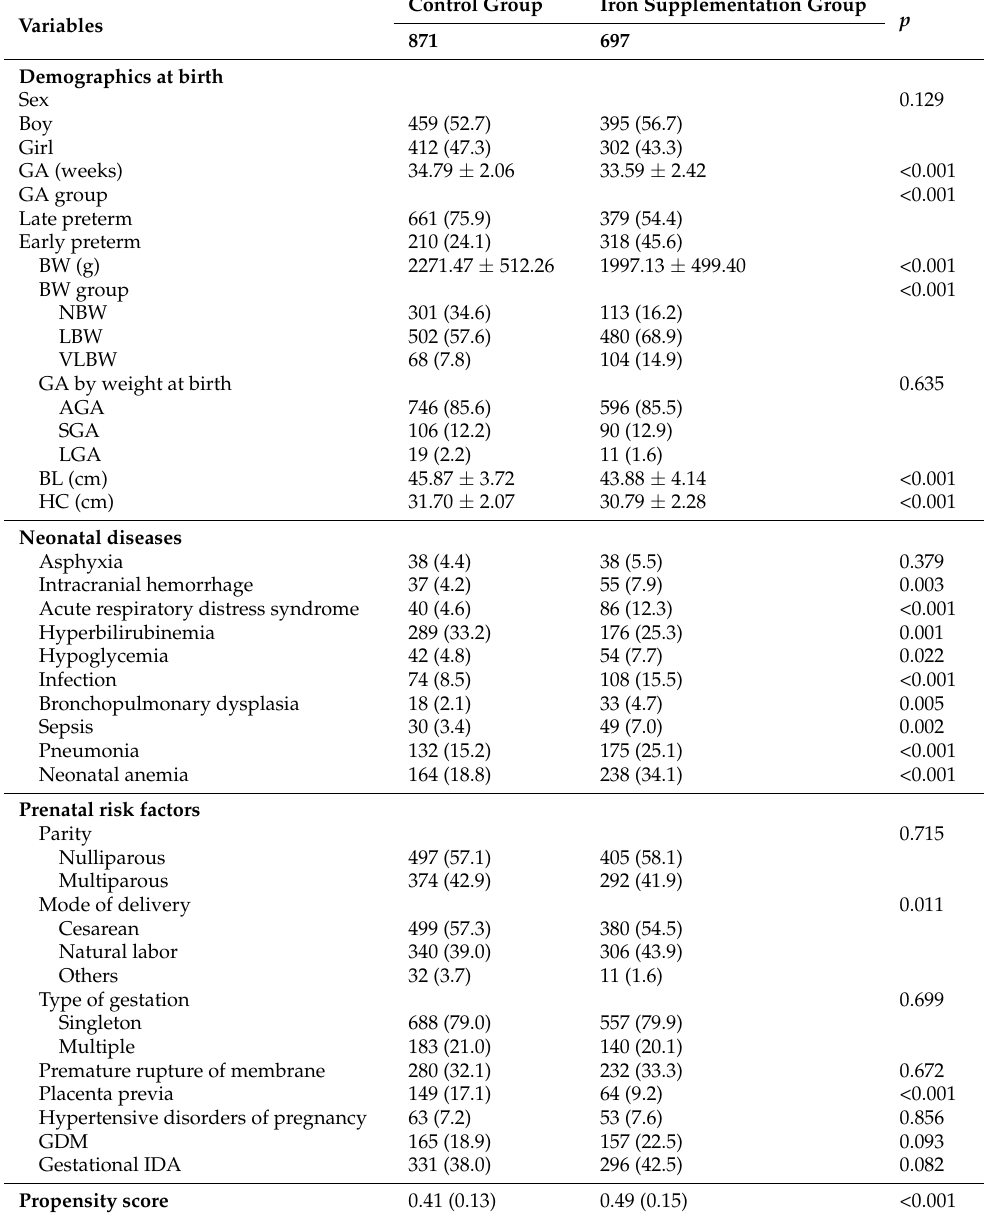
Table 1. Demographic characteristics, neonatal diseases, and prenatal risk factors in the control group and iron supplementation group at